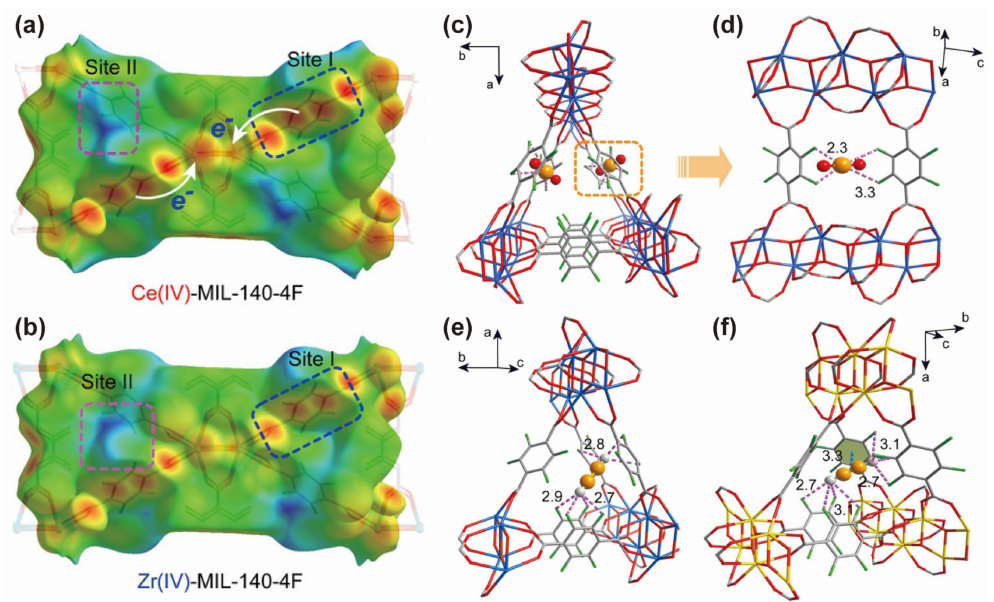
Figure 7. ( a , b ) The Hirshfeld surface with d e (ESP) in Ce IV -MIL-140-4F ( a ) and Zr IV -MIL-140-4F ( b ) (gradient color from red to blue indicates changes in electron density from high to low). ( c , d ) Structure of CO 2 -loaded Ce IV -MIL-140-4F and the interaction between CO 2 and F atoms. ( e , f ) The binding sites of C 2 H 2 in Ce IV -MIL-140-4F ( e ) and Zr IV -MIL-140-4F ( f ). Reproduced with permission from Zhang et al., Angewandte Chemie International Edition; published by John Wiley and Sons, 2021